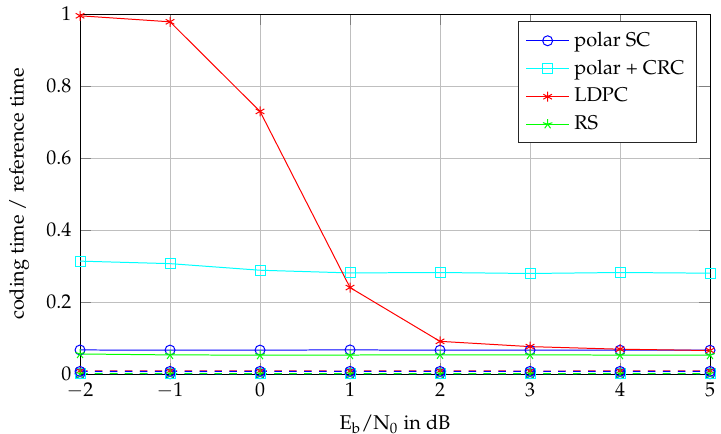
Figure 2. Average encoding time (dashed line) and decoding time (solid line) normalized to the reference time.